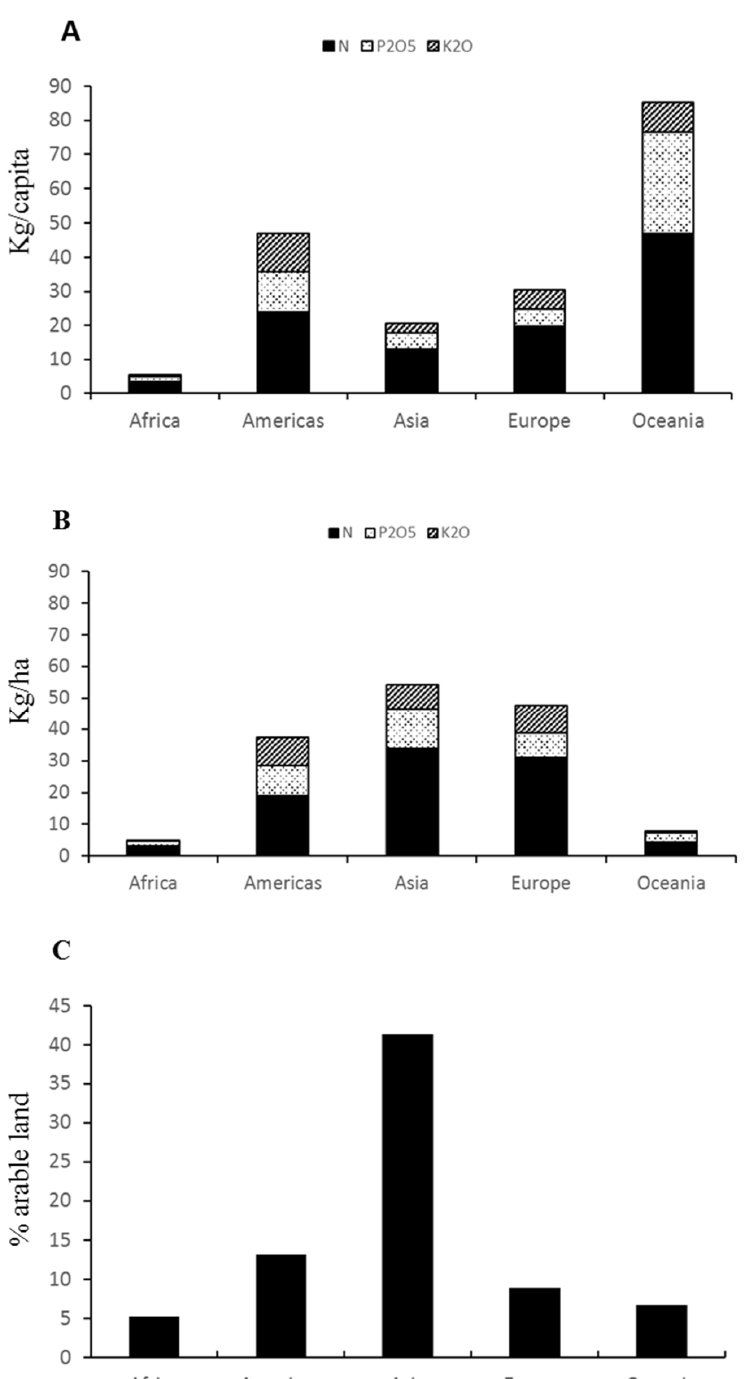
Figure 2. Agricultural input use is the lowest in Africa. ( A ) Fertilizer use (kg nutrient per capita of the population); ( B ) fertilizer use (kg nutrient per ha of agricultural land; and ( C ) irrigation use (% of arable land). Americas refers to both North and South America as well as the Caribbean. Adapted from: FAOSTAT.